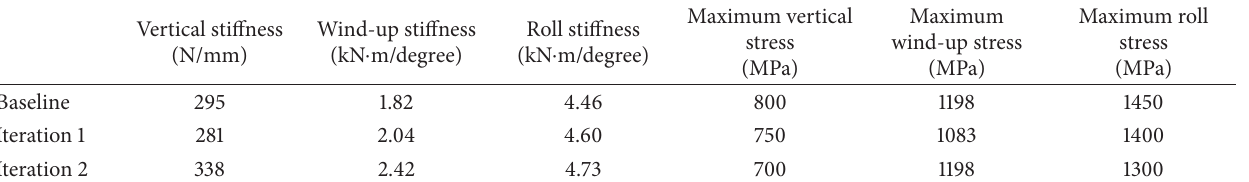
Table 2: Summary of vertical, wind-up, and roll stiffness and stress for Baseline, Iteration 1, and 2.